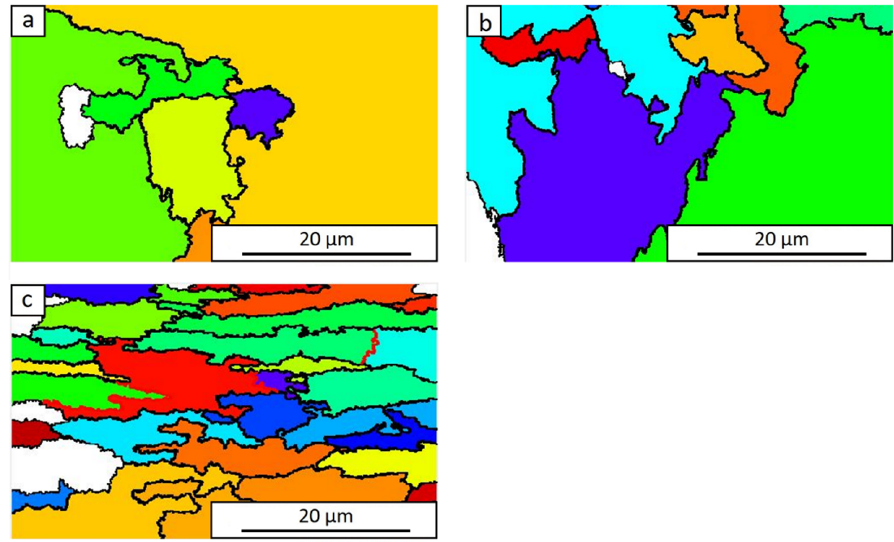
Figure 7. Primary austenite grain boundaries generated by the ARPGE program after continuous compression of samples at 1100 °C for deformation: 0.2 ( a ), 0.4 ( b ), 0.69 ( c ). Table 2. Results of grain size measurements as a function of deformation value; deformation rate: 1 s − 1